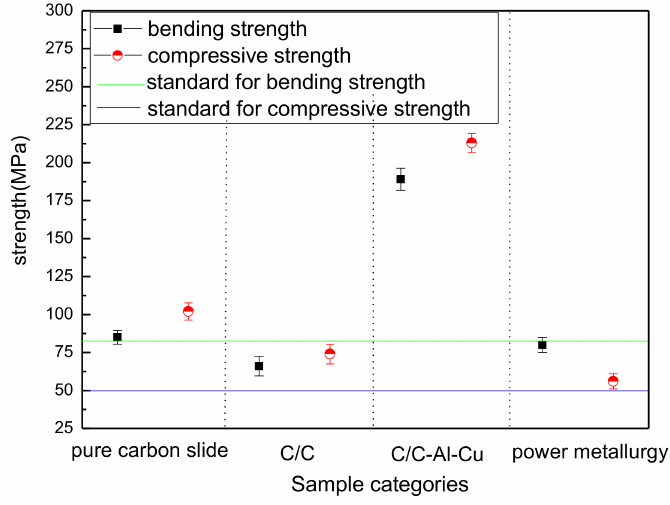
Figure 5. Testing error of the mechanical performance of